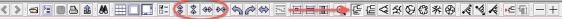
Dendroscope options.The circle shows the options for expanding/shrinking the tree, while the arrow points to the “phylogram” option.